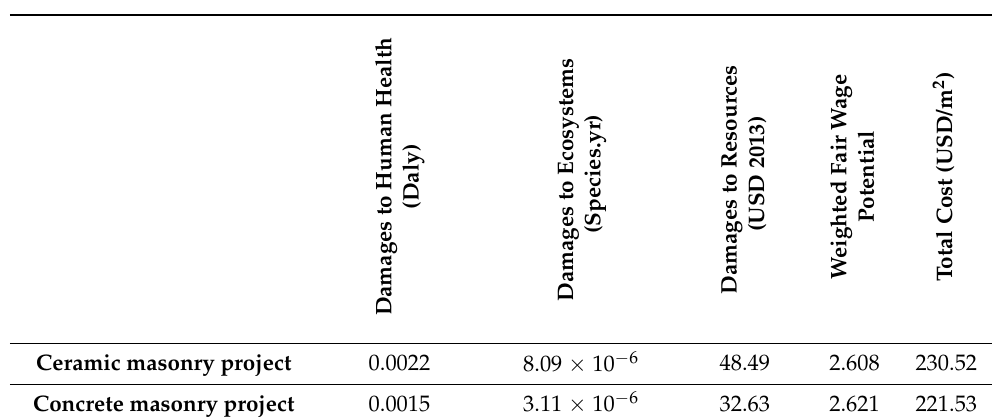
Table 15. Equal weights perspective: values of the criteria for determining